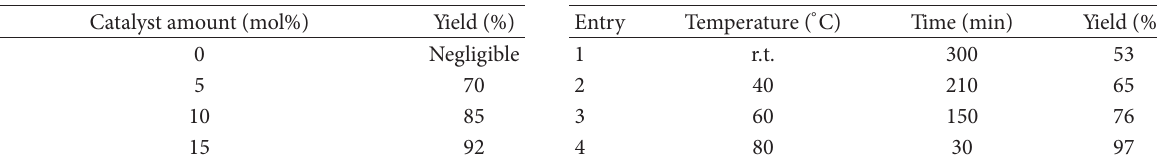
T 3: In�uence of temperature on the solvent-free synthesis of ethyl-6-methyl-4-phenyl-2-oxo-1,2,3,4-tetrahydropyrimidine-5- carboxylate in the presence of